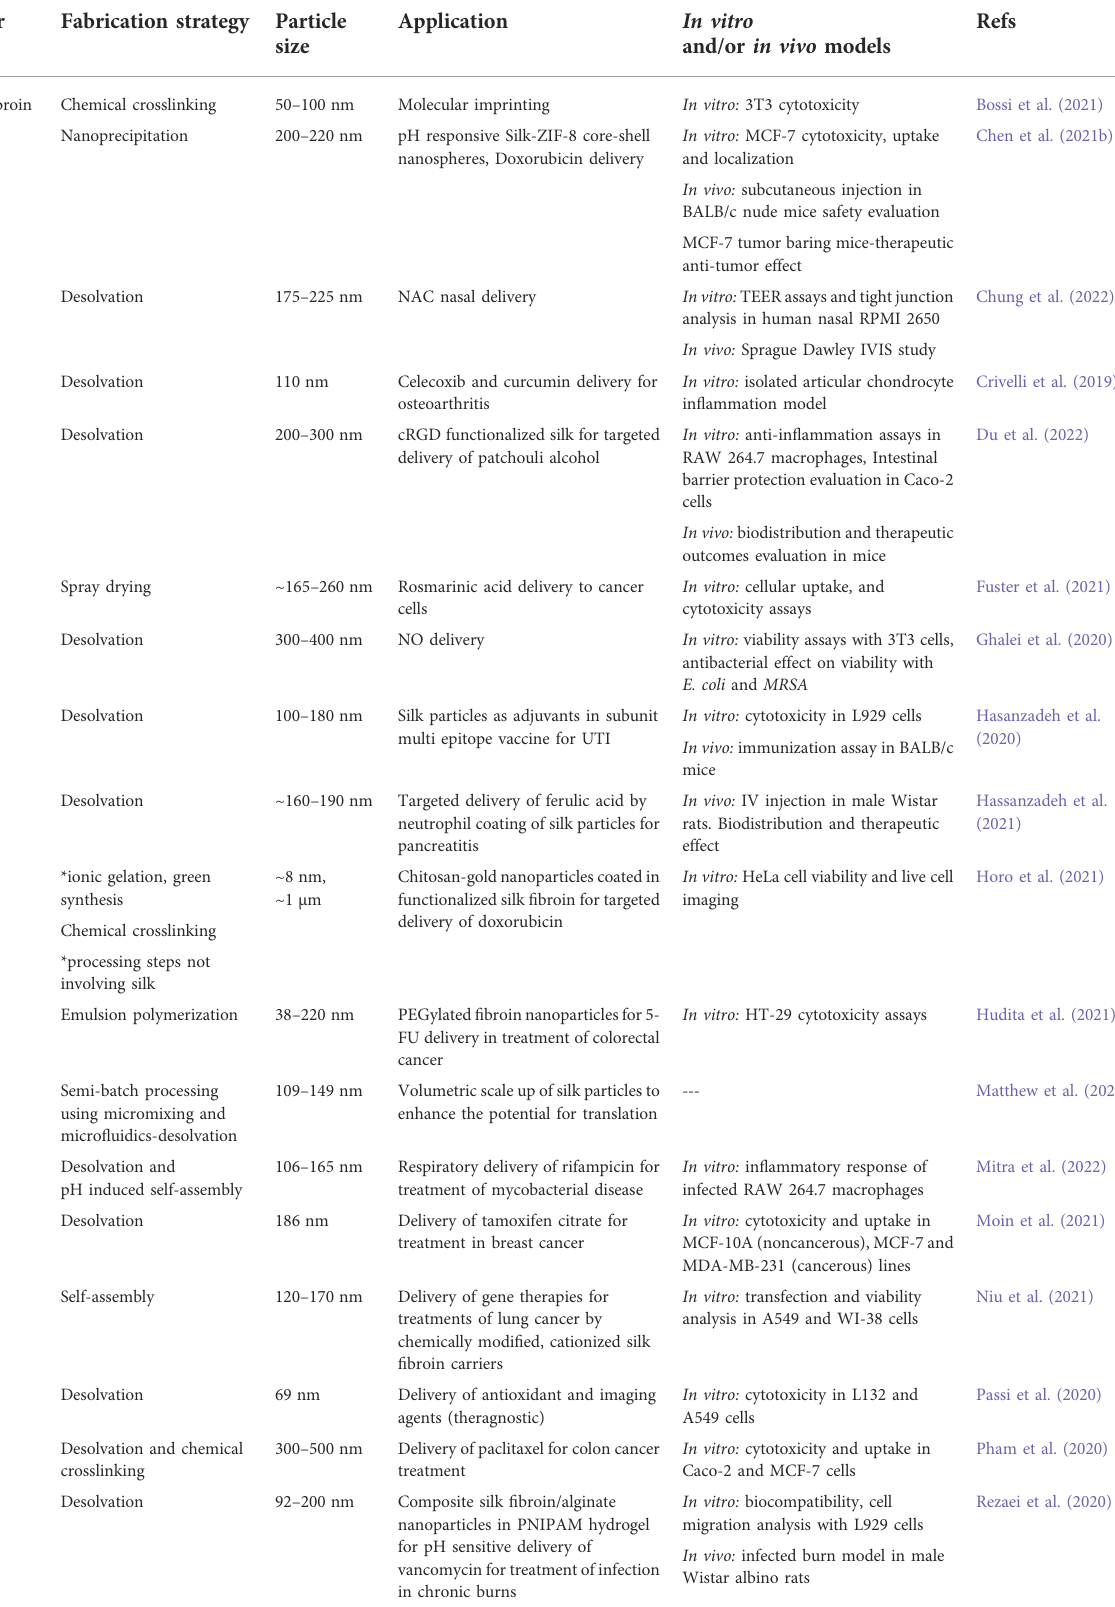
TABLE 1 Summary of current advances in silk and silk fi ber-inspired nanomaterials for drug and gene delivery. Polymer